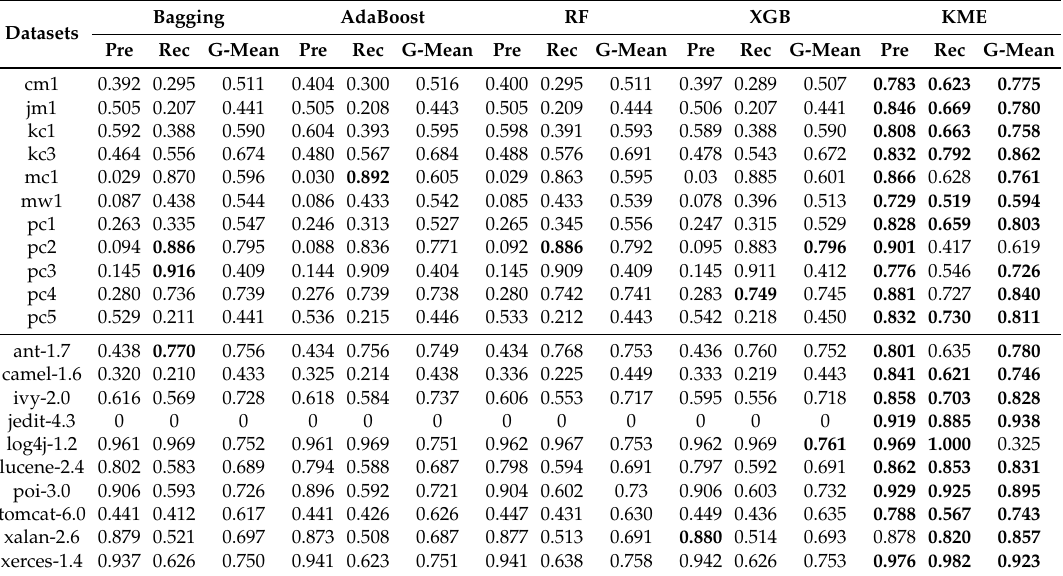
Table 6. Precision, Recall, and G-mean for the ensemble classifiers and KME. Datasets